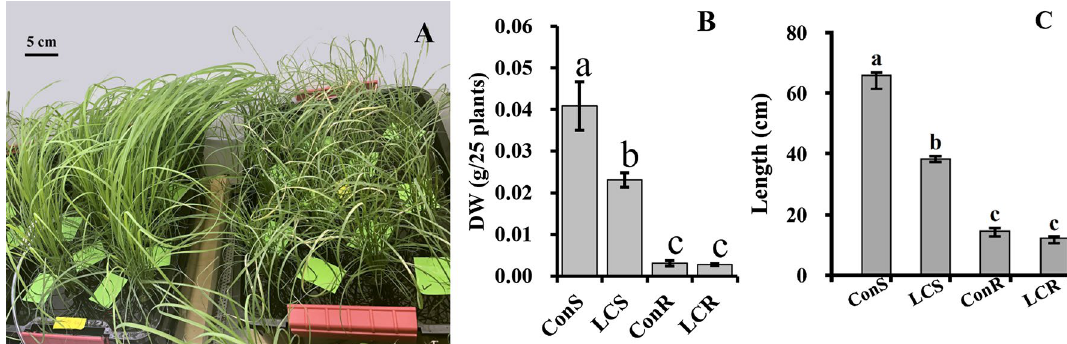
Figure 1. The phenotypic response of tef ( Eragrostis tef) plants to long-term Ca treatment. ( A ) Phenotypes of tef plants treated with low (10 µM) or optimum or control (1 mM) calcium in modified Hogland’s hydroponics media for four weeks. The picture was taken using an Apple iPhone camera by AL-O. ( B ) Root and shoot biomass, and root length of tef plants grown in Hoagland solution containing 10 µM or 1 mM Ca. LCS, low calcium grown shoots; ConS, control/optimum Ca grown shoots. LCR, low calcium grown roots; ConR, optimum calcium treated roots. ( C ) Shoot and root length of tef plants grown under control (ConS and ConR) and low Ca (LCS and LCS) conditions. Bars represent mean and SD of at least 4 independent biological replicates, and different letters indicate statistically significant difference ( p < 0.05).